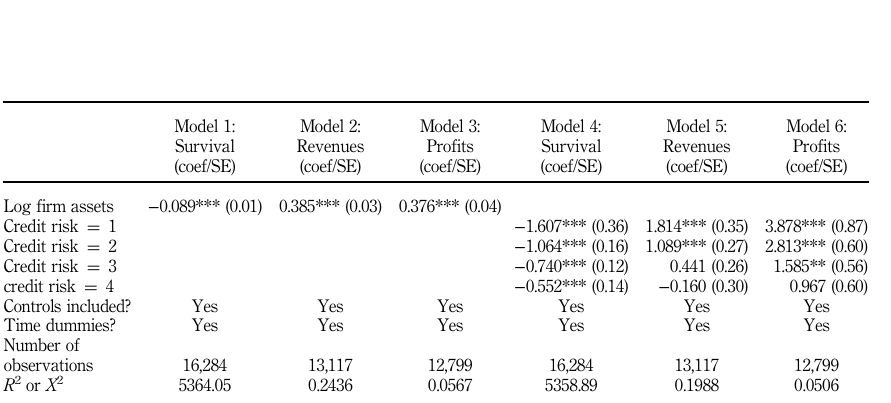
Table AII. Assets and